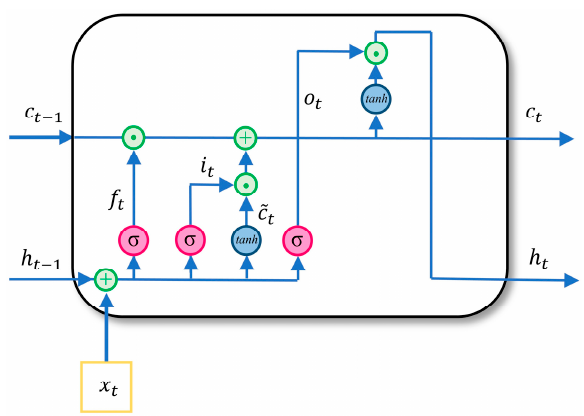
Figure 1. ConvLSTM cell architecture [35]. C t is the current state, C t − 1 is the state of the previous moment, o t is the output gate, i t is the input gate, f t is the forgetting gate, h t − 1 is the final output of the previous moment.